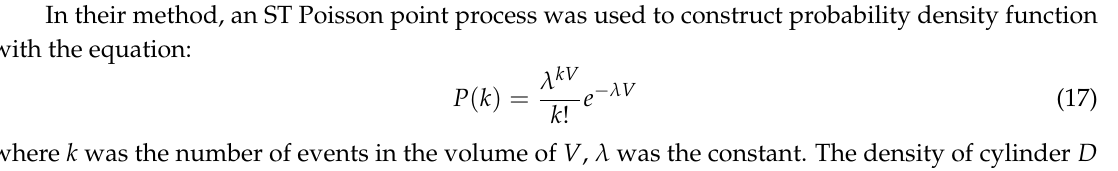
Figure 5. Spatiotemporal density connectivity (source: Pei, et al. [56]).